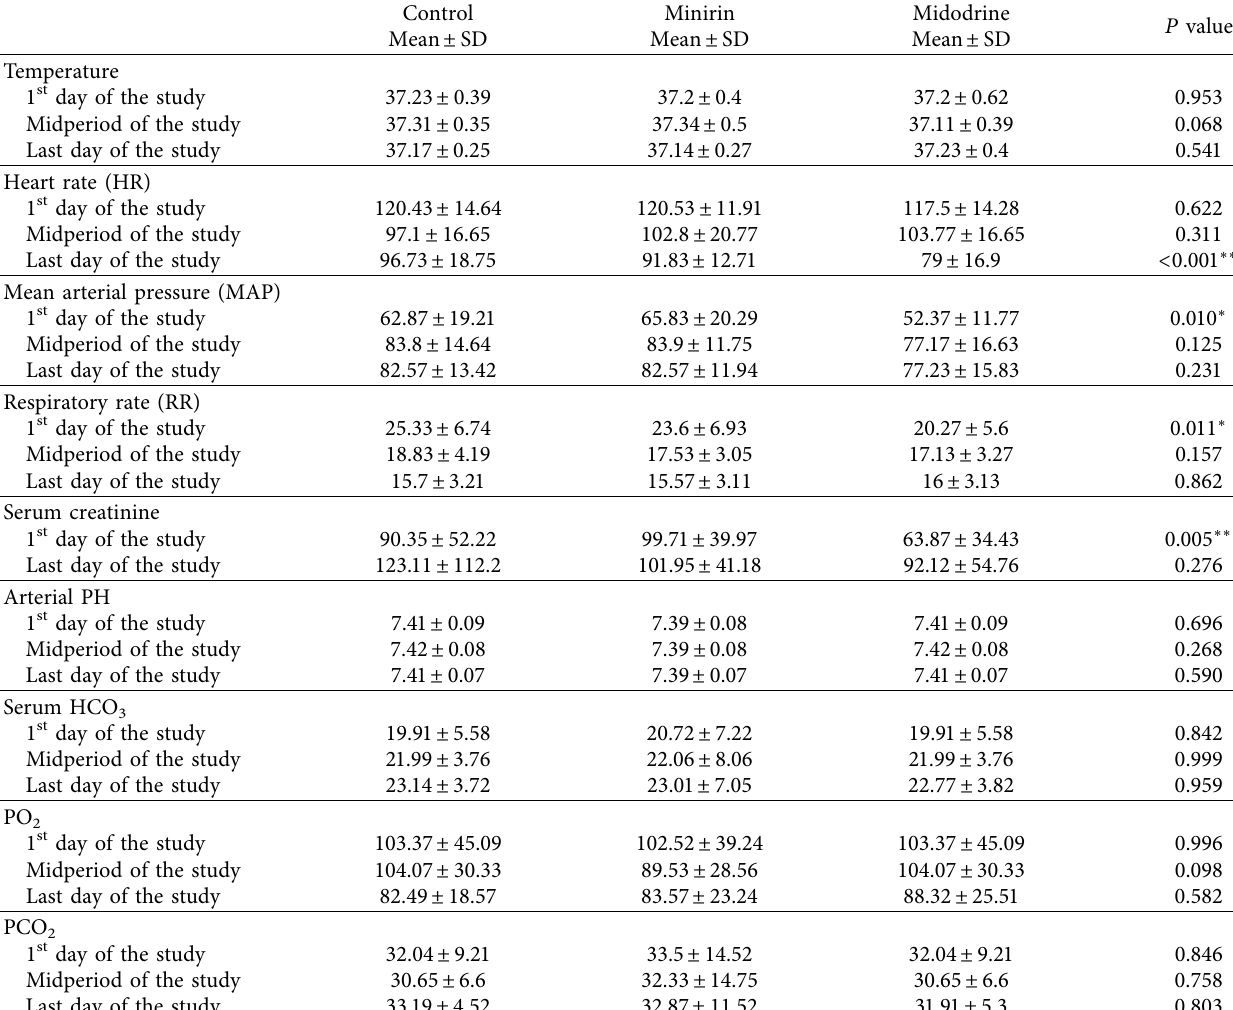
Table 2: Comparison between the studied groups regarding hemodynamic parameters and laboratory findings ( n � 90).